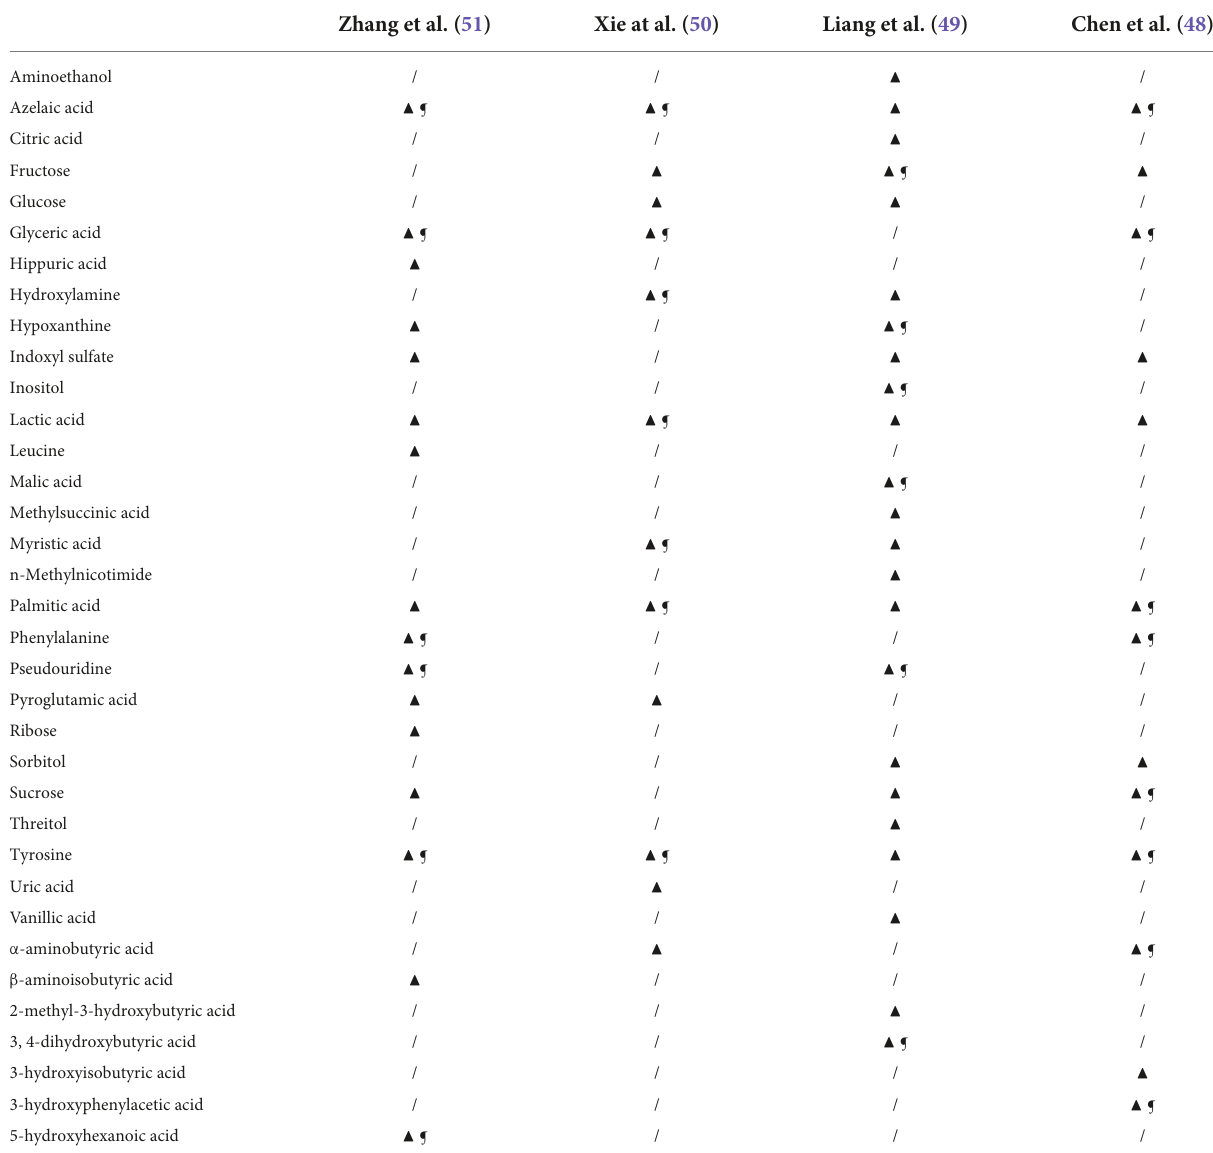
TABLE 3 Summary of all the differential urinary metabolites identified in the included studies. Urinary